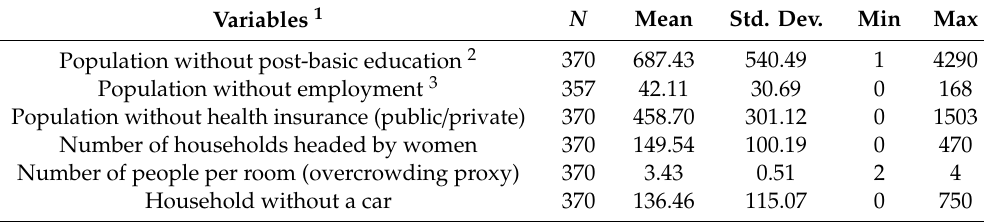
Table 1. Description of the socioeconomic variables included in the principal component analysis.